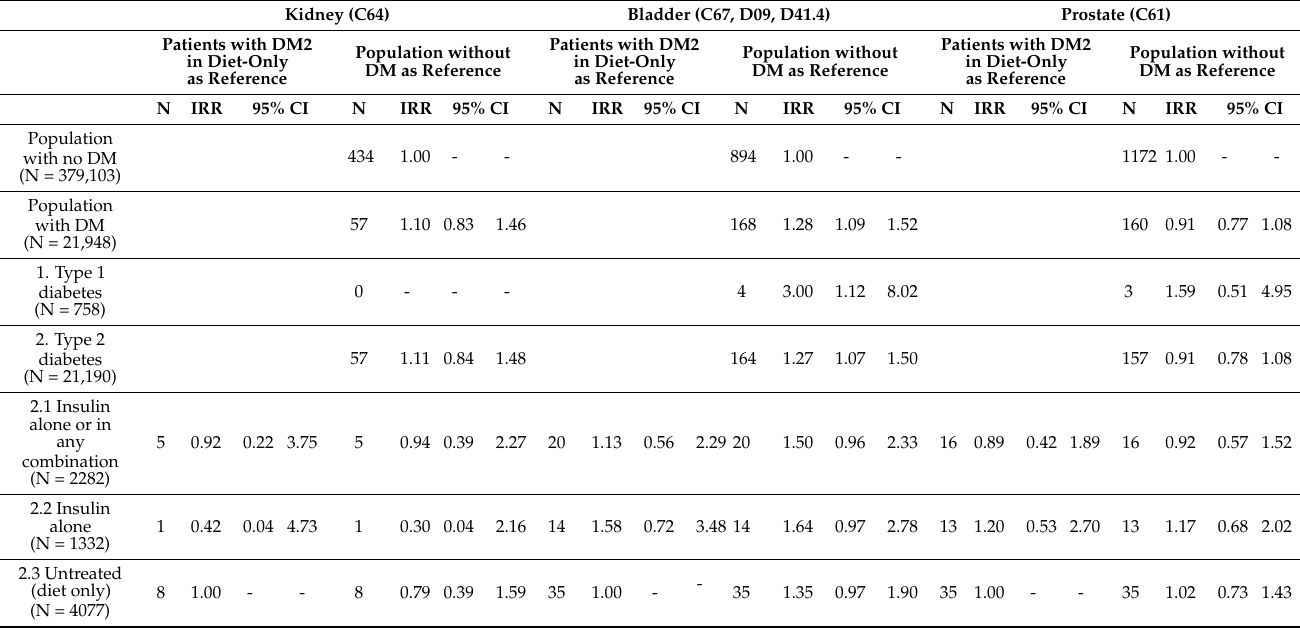
Table 6. Number, incidence rates ratios (IRR), and 95% confidence intervals (95% CI) of colorectal, pancreatic, liver, trachea, bronchus, and lung cancer, stomach cancer and lymphoma, corpus uteri, breast (women only), ovary, kidney, bladder, and prostate cancer by type of treatment with type 1 and type 2 diabetes (DM1; DM2). Reggio Emilia 2011-16, resident population aged 20–84 years. See Supplementary Material Table S6 for “other